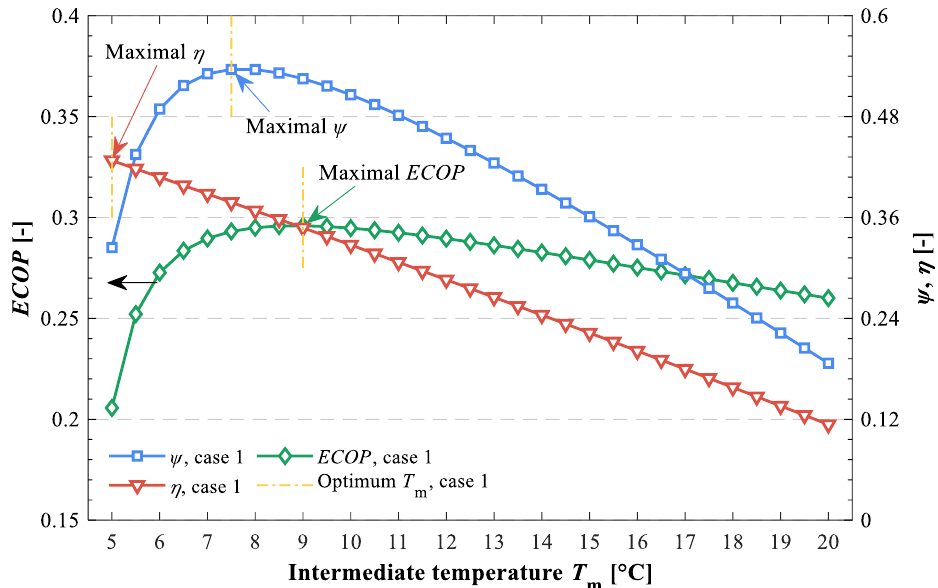
Figure 5. Effect of intermediate temperature on performance indicators for the layout with a cascade condensation process in case 1.